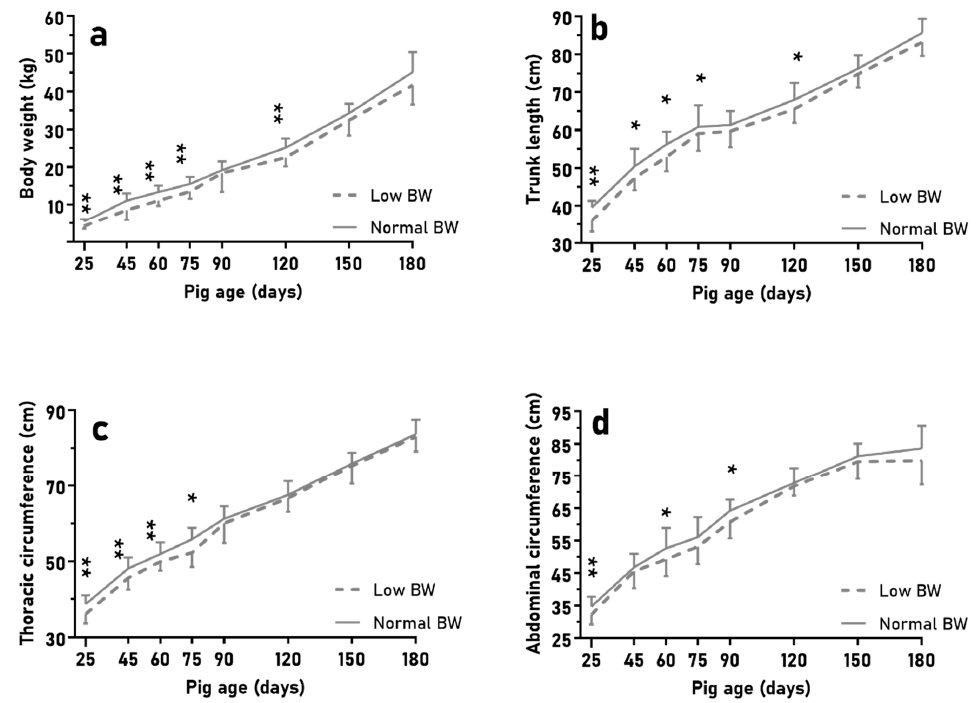
Figure 5. Mean values (±SD) of body weight ( a ), trunk length ( b ), and thoracic and abdominal circumferences ( c , d ) over the course of juvenile development (25 to 180 days old) when comparing low birth-weight(BW; ( n = 10) vs. normal BW piglets ( n = 22). Asterisks indicate significant di ff erences (* p < 0.05, ** p <